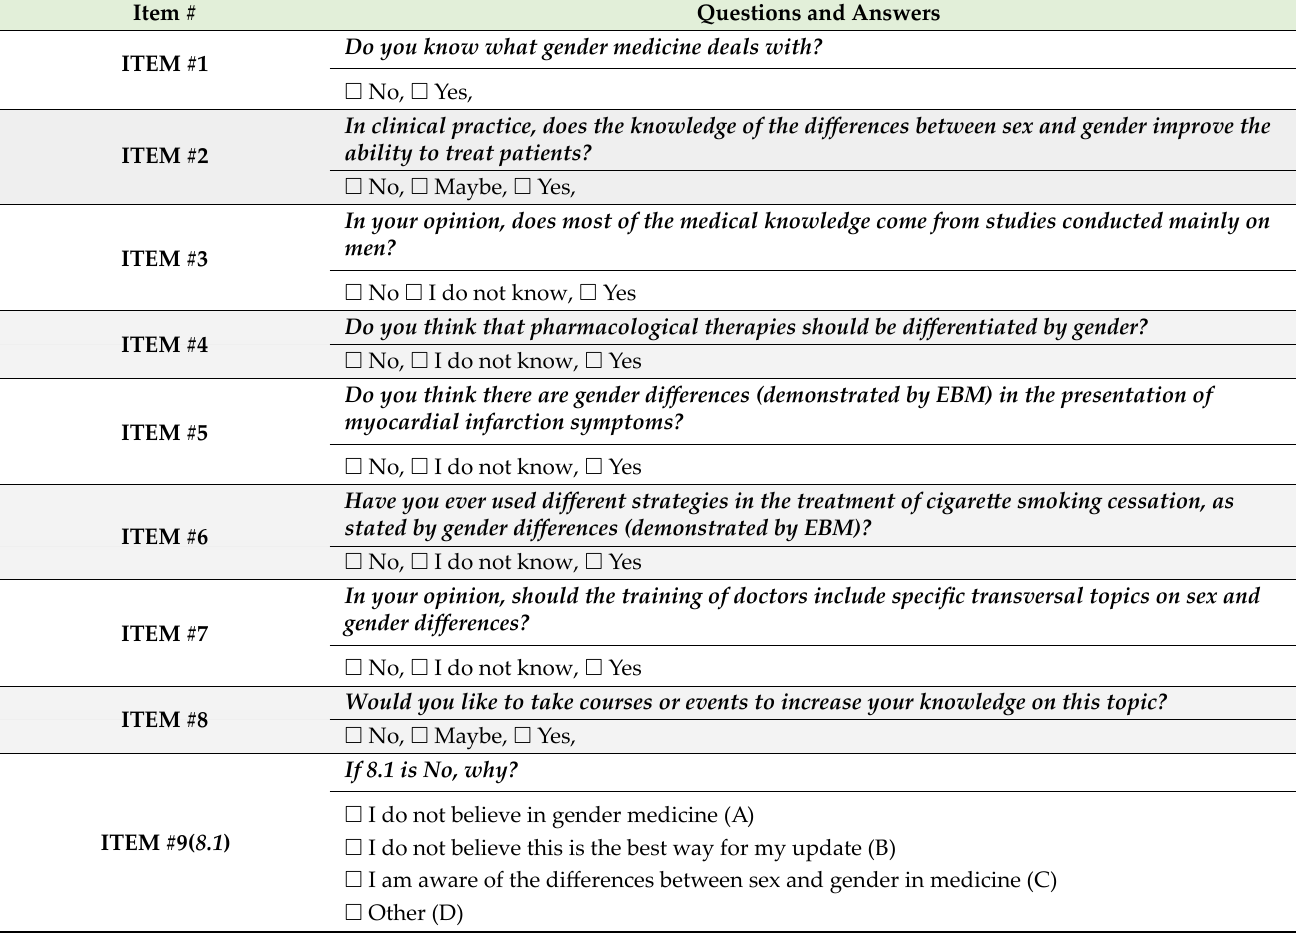
Table 2. Questions of the online